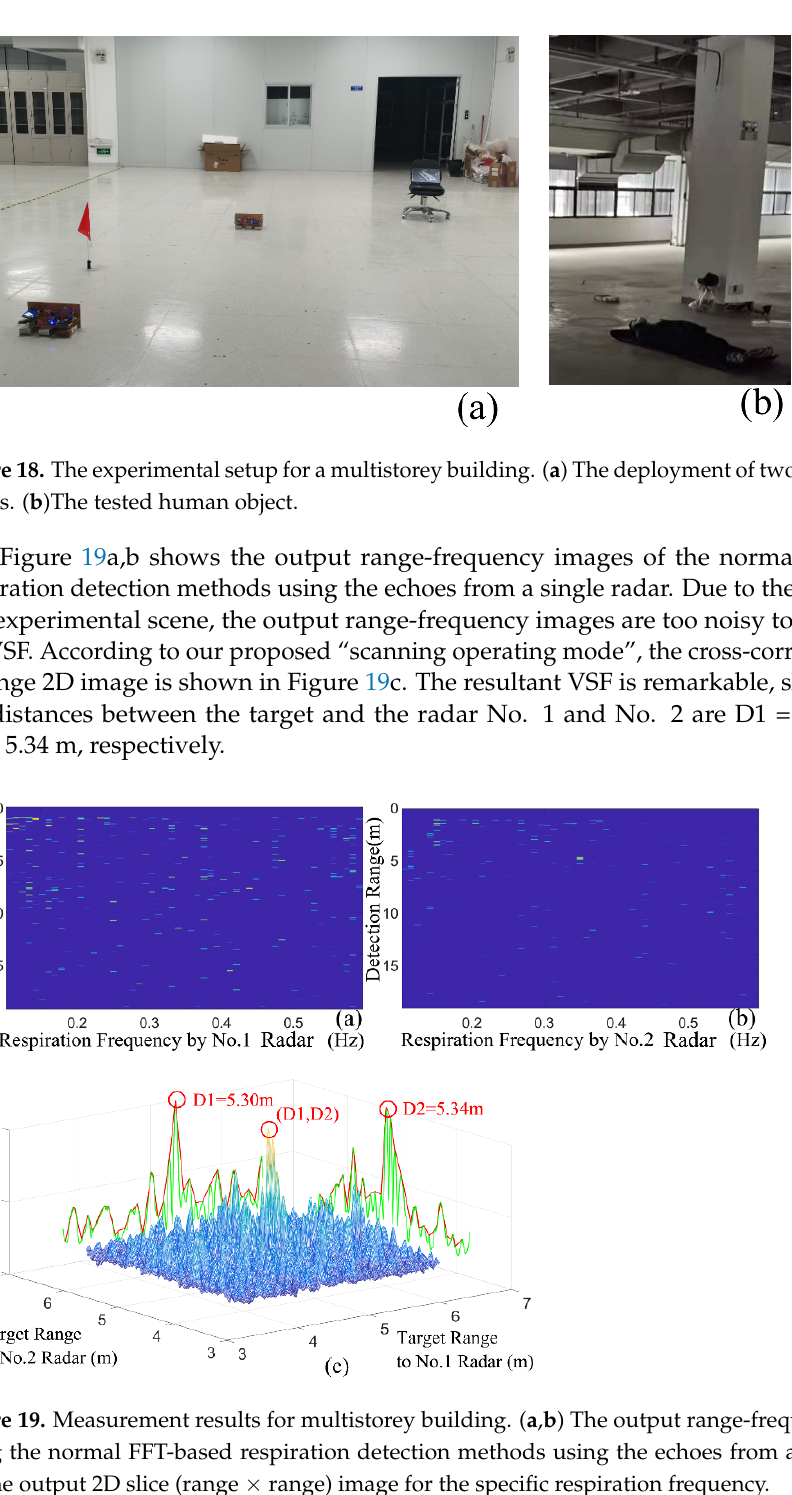
Figure 19. Measurement results for multistorey building. ( a , b ) The output range-frequency im- ages using the normal FFT-based respiration detection methods using the echoes from a single radar. ( c ) The output 2D slice (range × range) image for the specific respiration frequency.